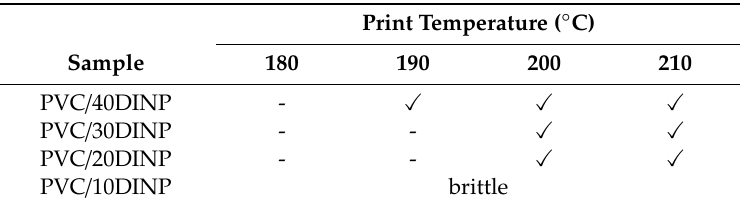
Table 2. Printing temperatures for di ff erent PVC / DINP